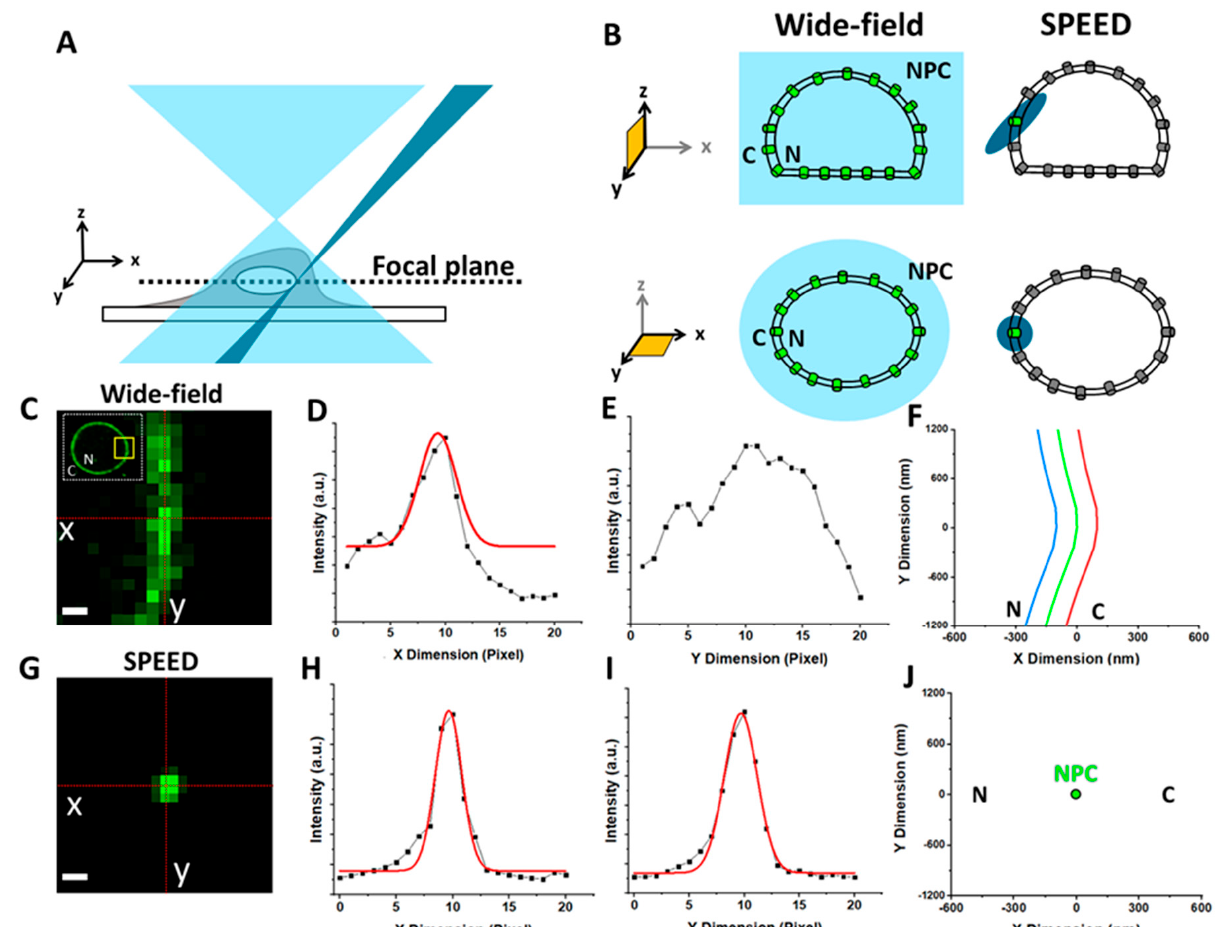
Figure 2. Illumination patterns of wide-field and single-point edge-excitation sub-diffraction (SPEED) microscopy techniques. ( A ) Diagramed illumination volumes of wide-field (light blue) and SPEED (blue) microscopy. ( B ) GFP-labeled NPCs embedded in the NE were highlighted inside (green) and outside (gray) the microscopy illumination volumes in the xy and yz planes [60]. ( C ) Selected area (yellow box) of GFP–NE florescence from wide-field illumination. The x- and y- axes are shown as dashed red lines intersecting at the NE equator. Scale bar, 0.5 µ m. ( D , E ) Intensities from a line scan of pixels (dashed red lines) in the x dimension and y dimension. ( F ) The middle plane of the NE, determined by the peak x dimension and y dimension intensities, is shown as a green curve. The blue and red curves refer to − 100 and +100 nm from the middle plane of the NE, respectively. ( G ) Single GFP–NPC excited with the illumination volume of SPEED microscopy. ( H , I ) The peak x and y position of the 2D line-scanning fitting from a single GFP–NPC fluorescent spot. ( J ) The 2D centroid of a single NPC determined by 2D Gaussian fitting. N , nucleus; C , cytoplasm. Figures were adapted from our previous publications with permission [61].